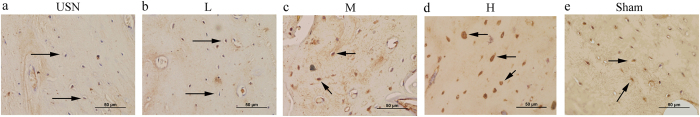
Sema3A expression in response to USN with or without naringin administration.(a) Immuno-histochemical staining of Sema3A in the femoral midshaft sections of rats from different treatments 4 weeks after USN showed decreased Sema3A-positive intensity in the osteocytes that were distributed in the femoral diaphysis of the USN rats but significant up-regulation in the naringin-treated rats, especially at higher doses of naringin. L represents the 30 mg/kg Naringin group, M the 100 mg/kg Naringin group, and H the 300 mg/kg Naringin group. Magnification ×400. Full-length blots are presented in Supplementary Figure S2.